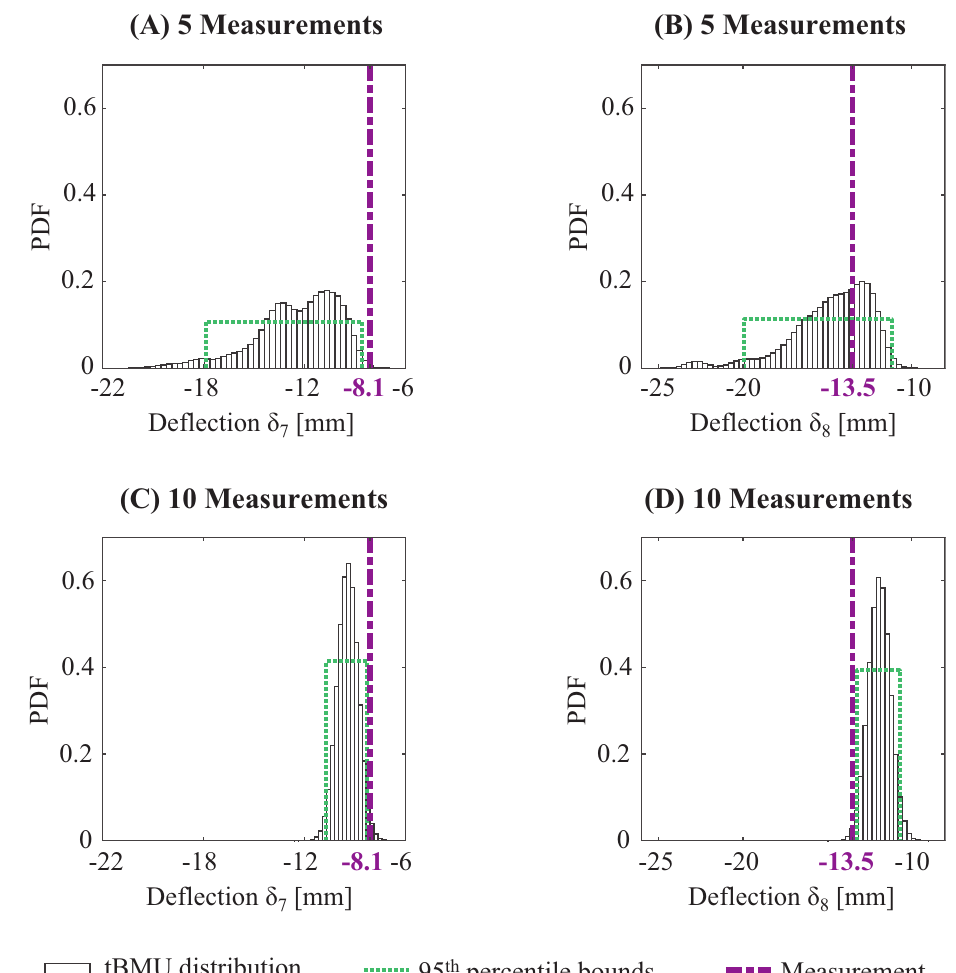
Figure 14. Leave-one-out cross validation for sensors 7 ( A , C ) and 8 ( B , D ) before ( A , B ) and after ( C , D ) including measurements at the same span in structural identification for the Cret-de-l’Anneau bridge. Although inclusion of measurements from the same span increases precision, 95th-percentile bounds are not compatible with measurements in both cases. In addition, displacement is overestimated for sensor 7 ( C ) and underestimated for sensor 8 ( D ), which shows that results are not always